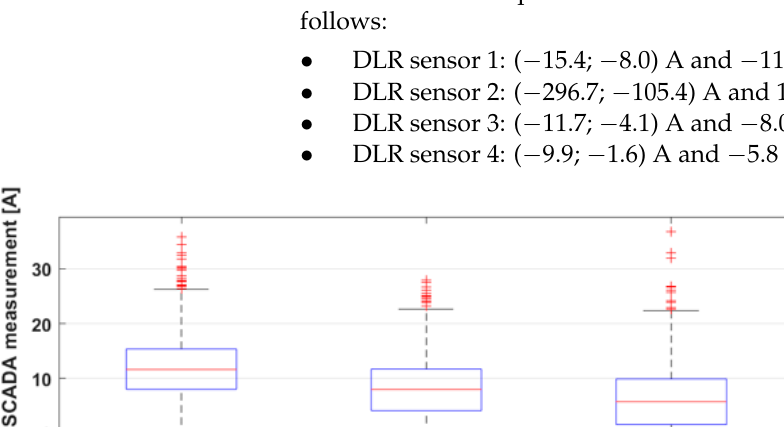
Figure 2. Line load measurement result, April 2020: ( a ) Measurement results of line monitoring sen- sor 1 compared to data from the SCADA system; ( b ) Measurement results of line monitoring sensor 2 compared to data from the SCADA system; ( c ) Difference between the maximum and minimum of the measured load values.